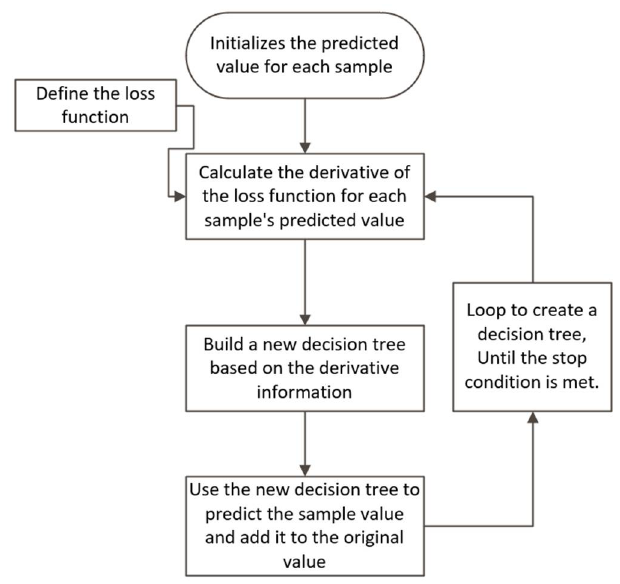
Figure 3. XGBoost algorithm flow chart.